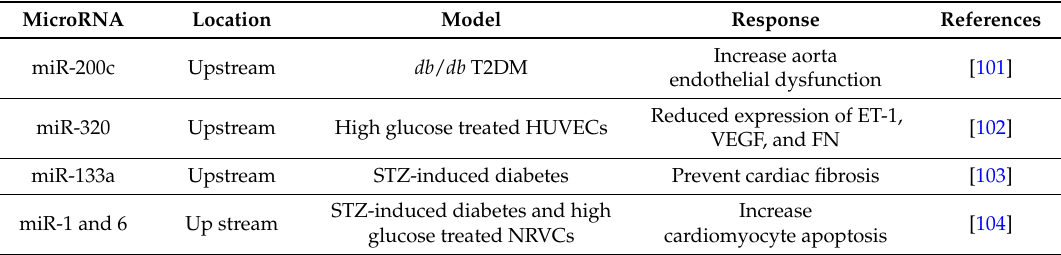
Table 2. MicroRNAs involved in an ERK1/2